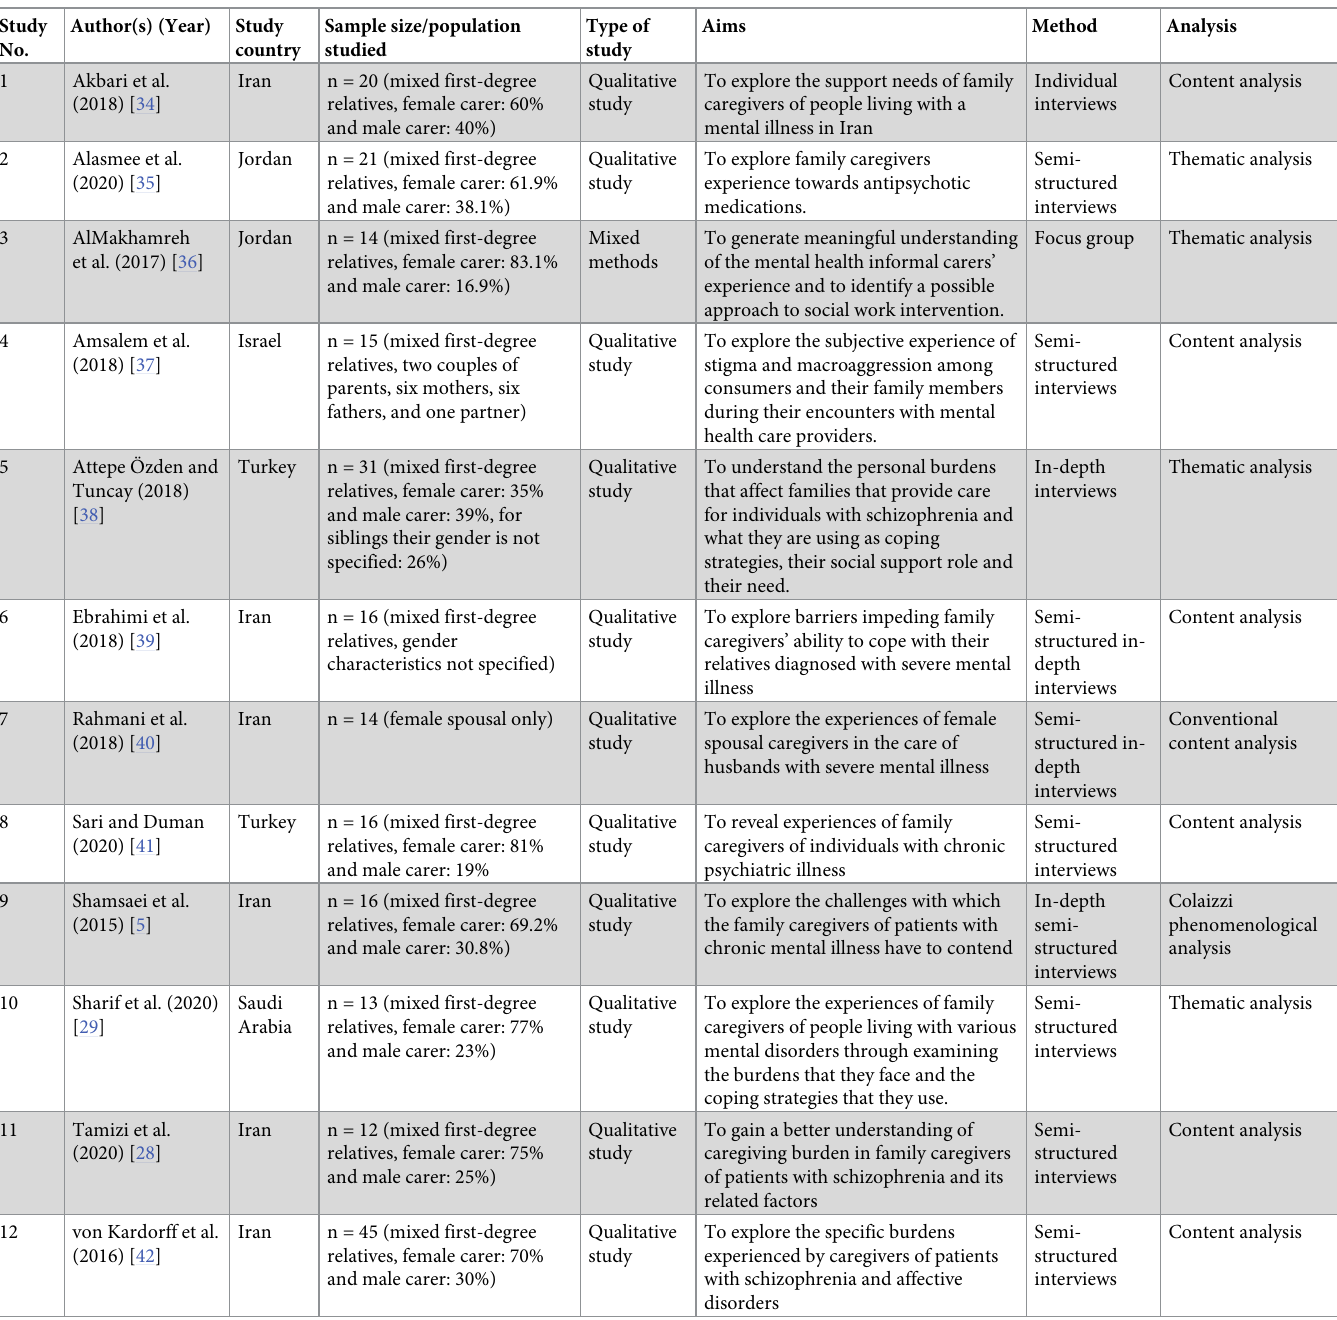
Table 1. Characteristics of included